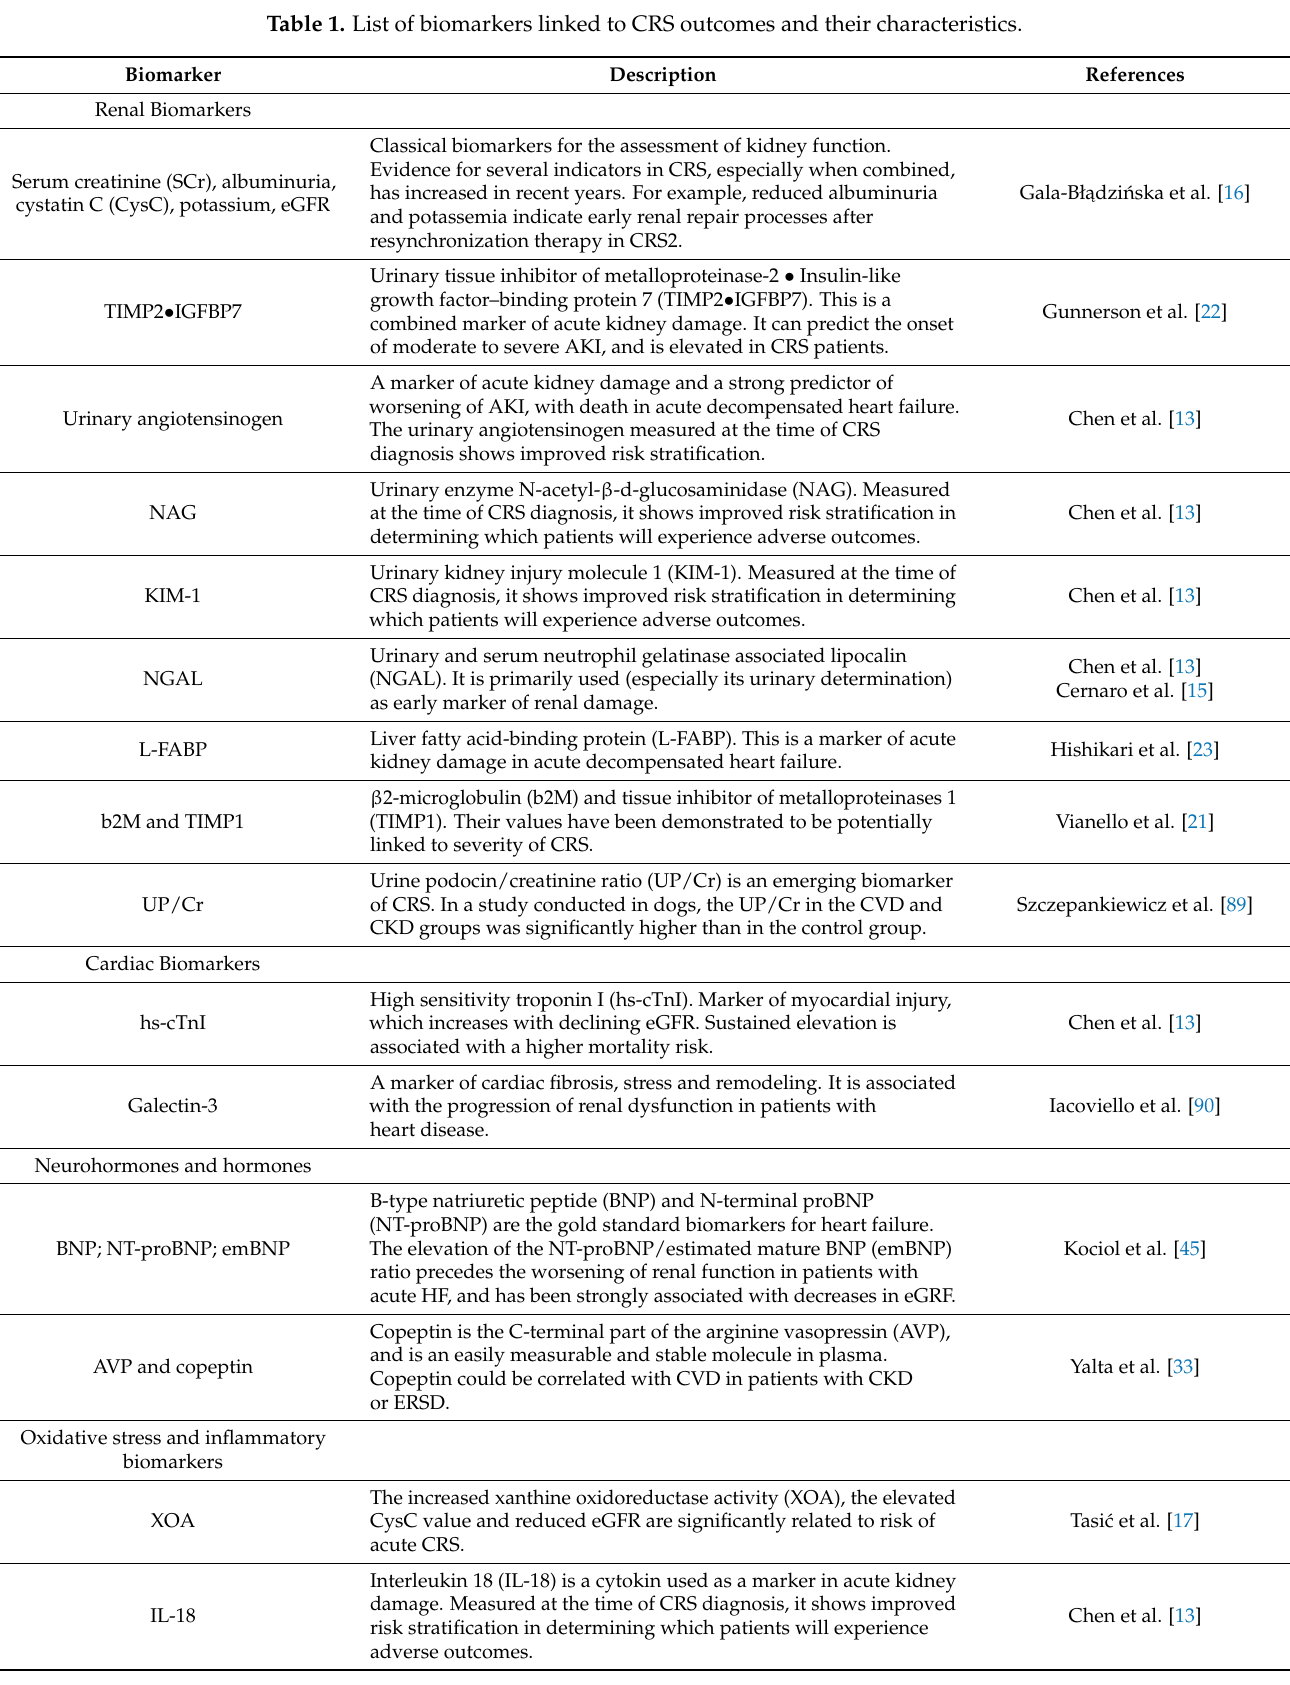
Table 1. List of biomarkers linked to CRS outcomes and their